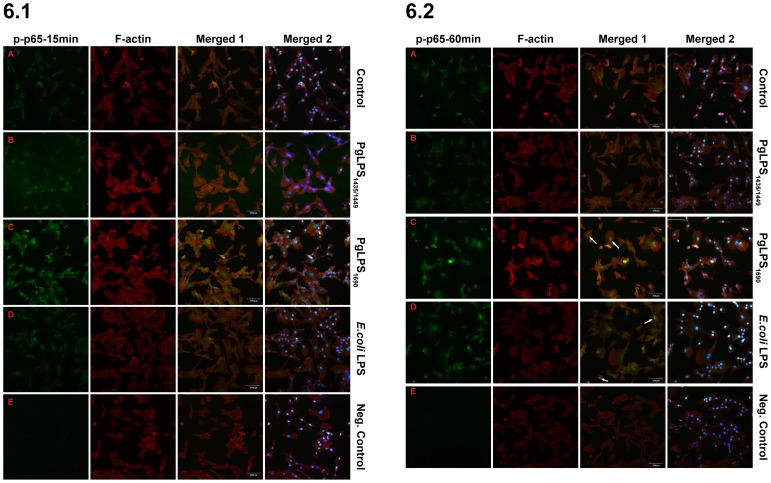
Confocal images of p-p65 NF-κB nuclear translocation in LPS treated HGFs.The cells were left untreated (A) or stimulated with P. gingivalis (Pg) LPS1435/1449
(PgLPS1435/1449) (B), PgLPS1690 (C) and E. coli LPS (D) (1 µg/ml) for 15 min (6.1) and 60 min (6.2), respectively. Cells were permeabilized with 0.1% Triton X-100 and subsequently stained with primary antibodies against anti-phospho p65-NF-κB and the correspondent secondary antibody labeled Alexa fluor 488 anti-rabbit, and subsequently stained with alexa fluor 555 phalloidin for F-Actin. The cytoplasmic p-p65 NF-κB appears in green color and F-actin is shown in red color. Negative control: E. The arrow heads show the prominent nuclear staining in the nucleus. Merged 1 images present the combined p-p65- NF-κB and F-actin, whereas Merged 2 images show the combined p-p65-NF-κB, F-actin and nuclear staining which is counterstained with DAPI. The experiment was performed three times, and the pictures observed correspond to a representative field for each of the times studied. Scale bar = 100 um.